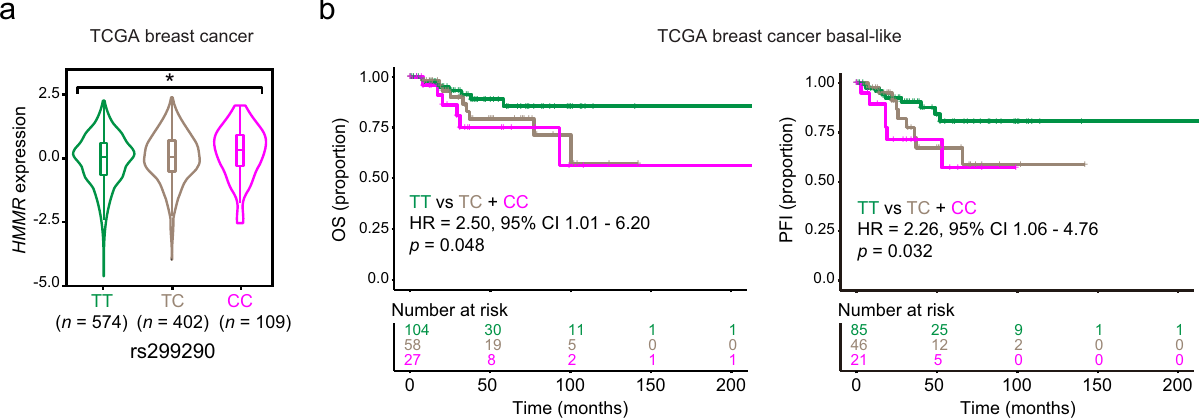
Fig. 2 rs299290 is a breast cancer HMMR eQTL and is associated with the outcome of basal-like cases. a Violin plot of HMMR expression in TCGA primary breast tumors according to rs299290 genotype (color-coded). In the box plots inside violin plots the horizontal lines represent the sample medians, the boxes extend from fi rst to third quartile, and the whiskers indicate values at 1.5 times the interquartile range. The number of tumors of each genotype is indicated. One-way ANOVA; * p = 0.033. b Kaplan – Meier plots showing the association between overall survival (OS; left panel) or progression-free interval (PFI; right panel) and rs299290 in basal-like breast cancer. The hazard ratio (HR), 95% CI, and log-rank p value between cases with rs299290-TT and TC + CC genotypes are shown. The number of patients at risk at each time point are also